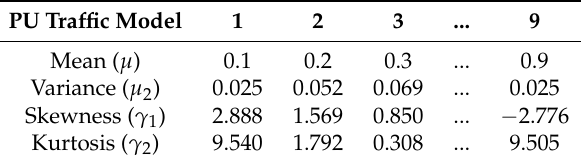
Table 3. Examples of the reference PU traffic